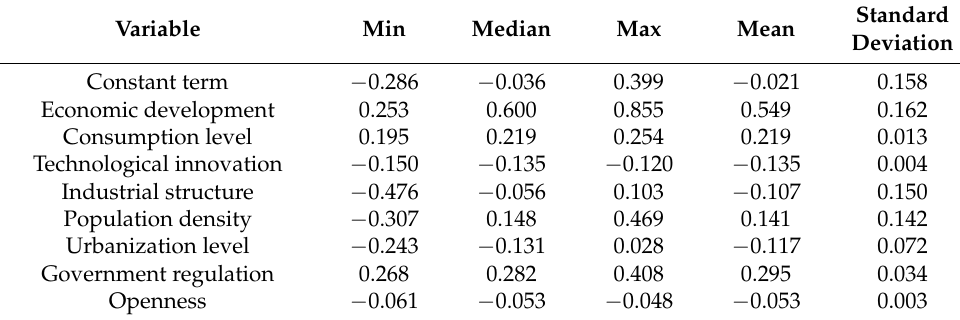
Table 5. Statistical description of MGWR regression